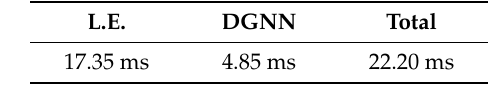
Table 2. Processing times of the proposed algorithm. L.E., landmark extractor.